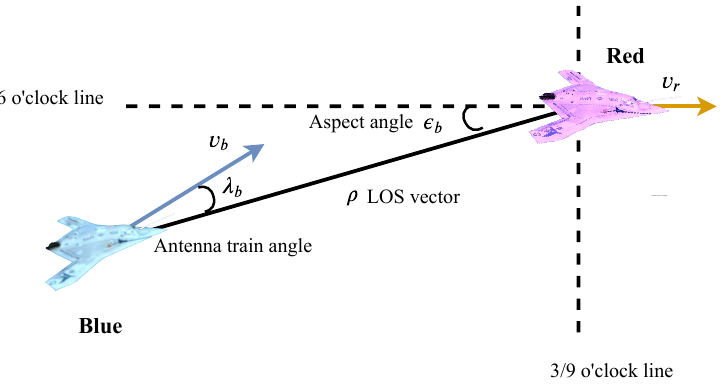
Figure 2. Aircraft relative geometry showing aspect angle and antenna train